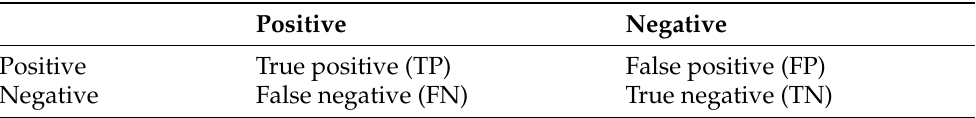
Table 4. Confusion